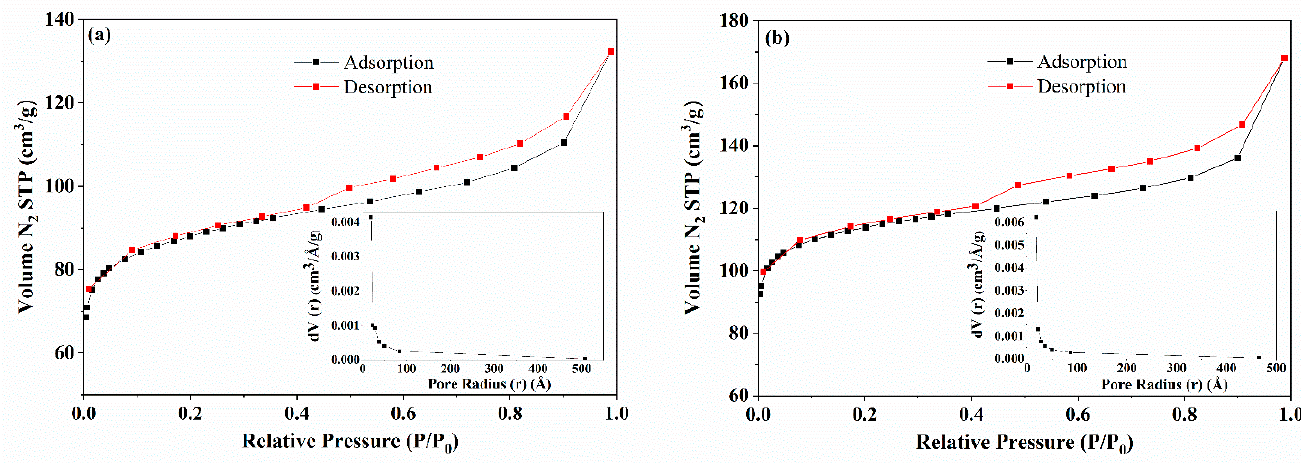
Figure 3. Nitrogen adsorption/desorption isotherms and the BJH pore size distribution of ( a ) MAC1105 and ( b ) MAC111.